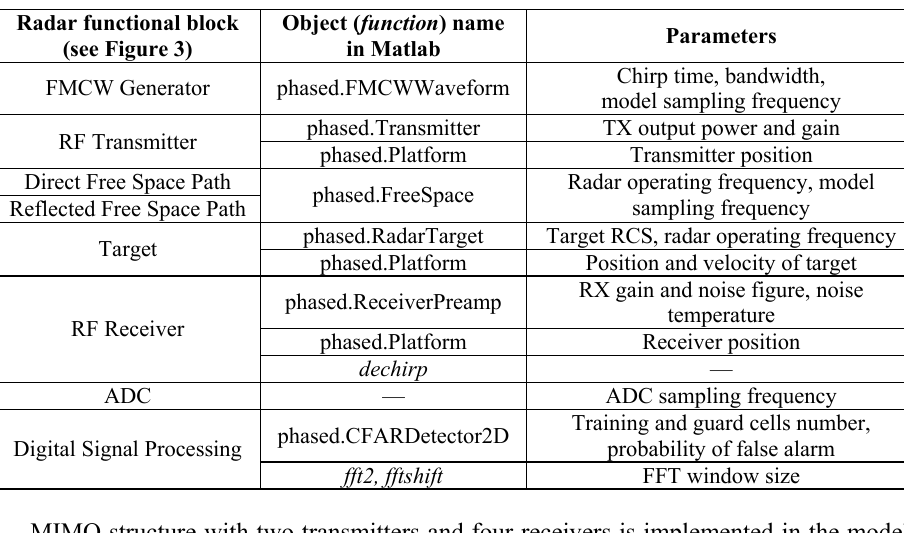
Table 1. Matlab objects and main functions used in the model.